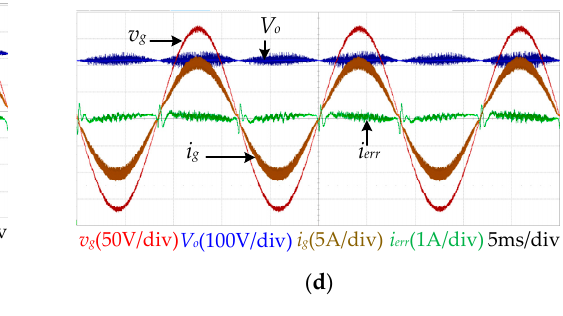
Figure 14. Experimental results under the 800 W condition in buck/boost mode under v g = 120 V rms , V o = 80 V(buck)/ V o = 220 V(boost): ( a ) without the repetitive controller in buck mode; ( b ) with the repetitive controller in buck mode; ( c ) without the repetitive controller in boost mode; ( d ) with the repetitive controller in boost mode.